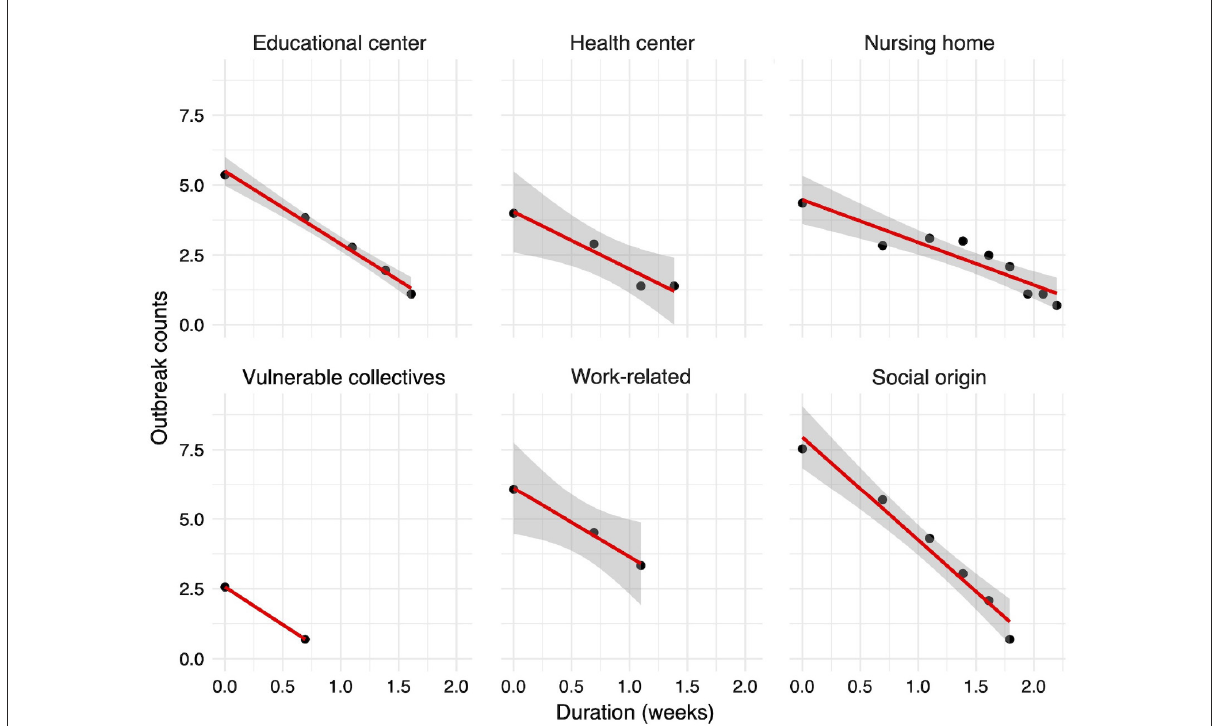
FIGURE7 Relationship between the outbreak duration in weeks and the number of reported outbreaks (both in logarithmic scale). The 95% confidence interval around the linear regression line is shown with gray color. For the vulnerable collectives, no interval is shown as only two data points are